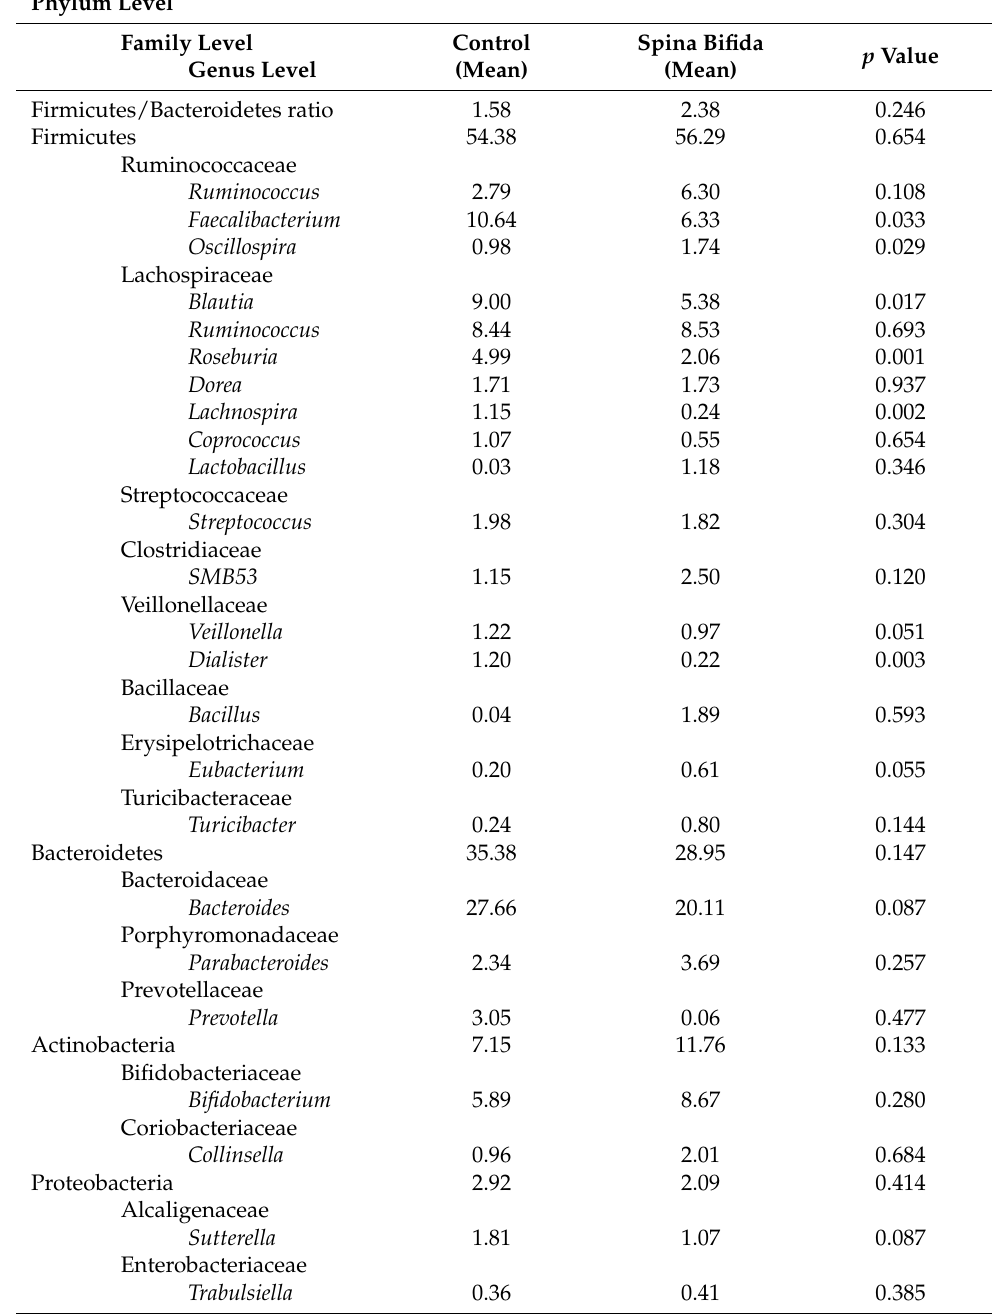
Table 2. Differences between gut microbiota in the SB patients and healthy